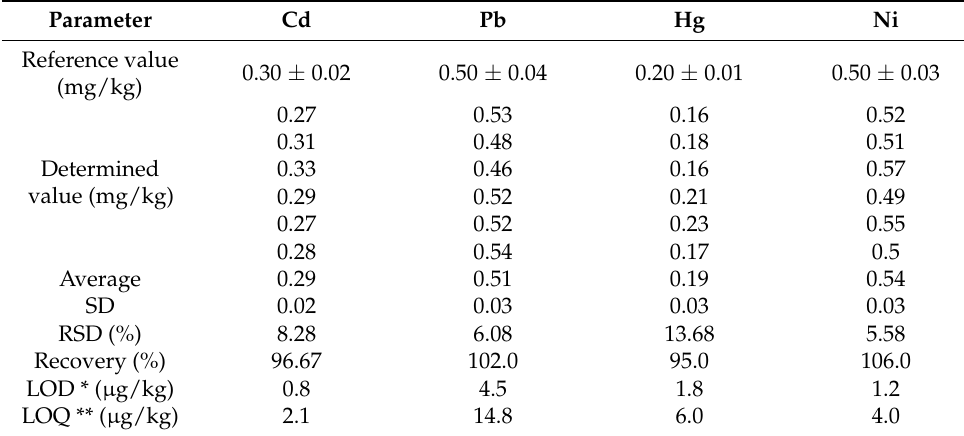
Table 2. Selective validation parameters of the applied